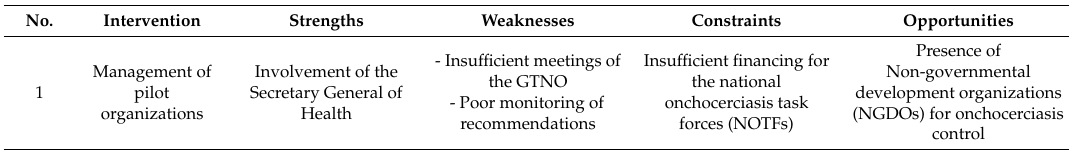
Table 5. Summary of the strengths, weaknesses, opportunities, and threats of CDTI implementation in the